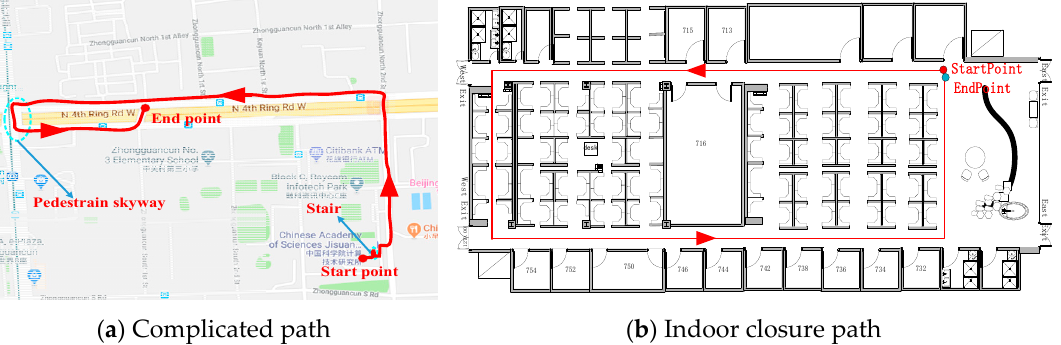
Figure 17. Walking path description. The volunteers were asked to travel the highlighted path with a natural pattern. Volunteer 1 (172 cm, 66 kg) walked along path a. Volunteer 2 (180 cm, 80 kg) walked along path b. Table 3. Comparison of walking-distance estimation in complex paths.